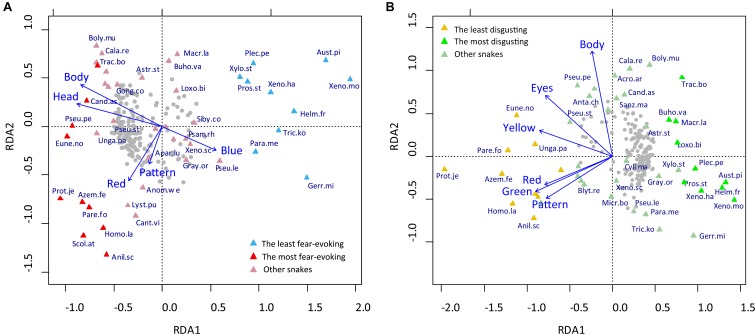
Redundancy Analysis (RDA) of the characters determining the ranks of fear and disgust elicited by snake stimuli used in Experiment 1. (A) Analysis of the fear ranks. The model explained 41.39% of the full variability, RDA1 = 0.2784% of variability and RDA2 = 0.0714% of variability. (B) Analysis of the disgust ranks. The full model explained 44.77% of the variability, RDA1 = 24.75% of variability, RDA2 = 10.76% of variability. For a better visualization of the fear/disgust ranks polarity, 10 species with the largest and lowest mean ranks of fear/disgust are mapped onto the pictures. For the description of the snake species abbreviations, see Supplementary Material 1.